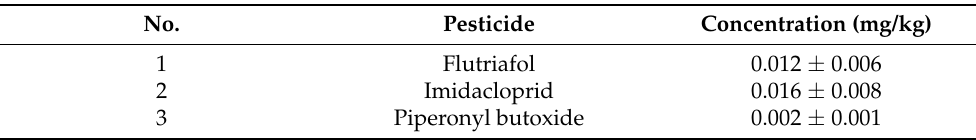
Table 3. Concentration of detected pesticides in a CS sample.